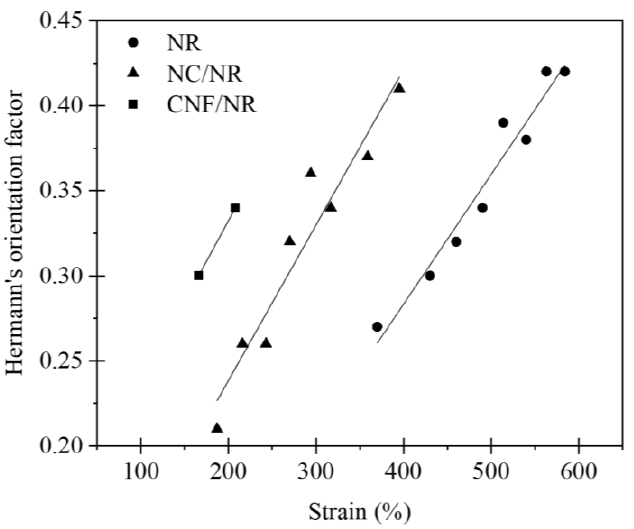
Figure 8. Variation of Hermann’s orientation factor (ƒ) as a function of applied strain for NR, NC/NR, and CNF/NR.